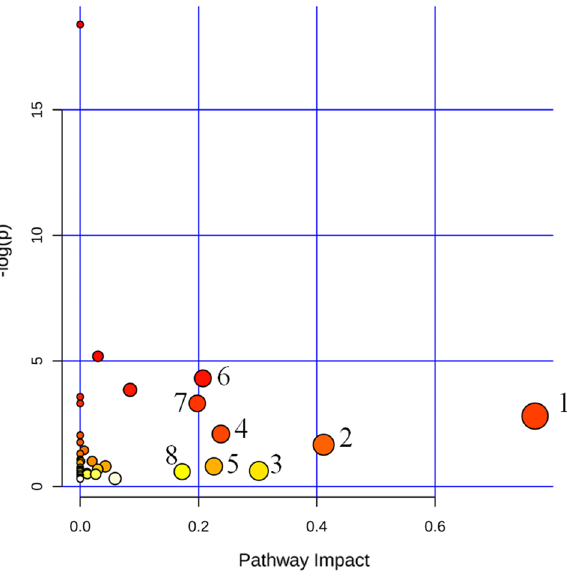
Figure 4. Pathway analysis overview showing the altered metabolic pathways in T. controversa -infected and noninfected samples based on KEGG (https:// www. kegg. jp/ kegg/ kegg1. html) pathway analysis 24 . 1 phenylalanine metabolism; 2 isoquinoline alkaloid biosynthesis; 3 starch and sucrose metabolism; 4 tyrosine metabolisms; 5 sphingolipid metabolisms; 6 arginine and proline metabolism; 7 alanine, aspartate and glutamate metabolism; and 8 tryptophan metabolisms. A pathway with an impact value greater than 0.1 was considered a potential